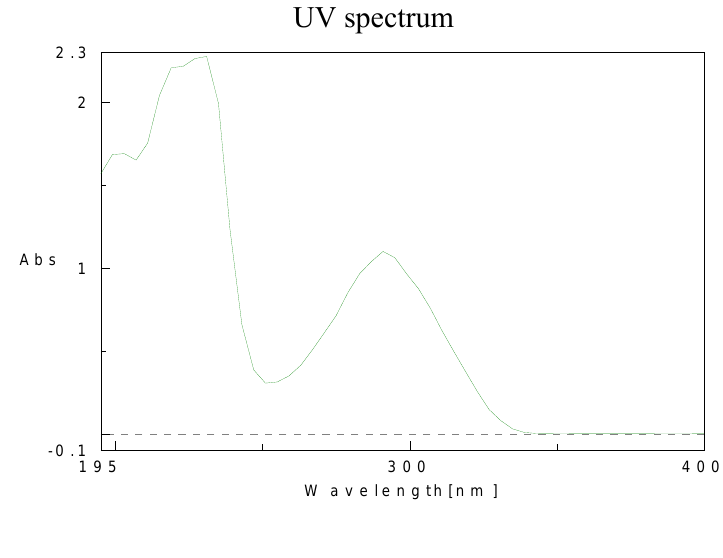
( E )-Methyl 3-(naphthalen-1-yl)but-2-enoate [( E )-1e] Yellow oil. R ( n -hexane/ethylacetate 98:2); 1 H-NMR (CDCl )  ppm): 2.66 (d, 3H, J = 1.1 Hz), 3.82 (s, 3H), 3 6.02 (q, 1H, J = 1.1 Hz), 7.31 (dd, 1H, J =7.0, 1.1 Hz ), 7.45-7.50 (m, 1H), 7.50-7.55 (m, 2H), 7.84 (  d, 1H, J = 8.3 Hz ), 7.87-7.94 (m, 2H); HPLC-UV/PAD analysis: RT 4.7 min. UV spectrum -13 012